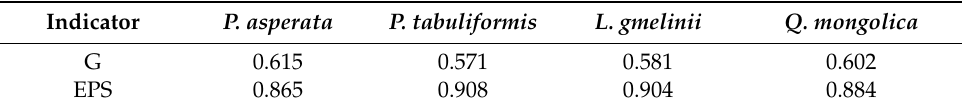
Table 3. Gini-coe ffi cient (G) and Expressed Population Signal (EPS) for the ARI series of the four investigated tree